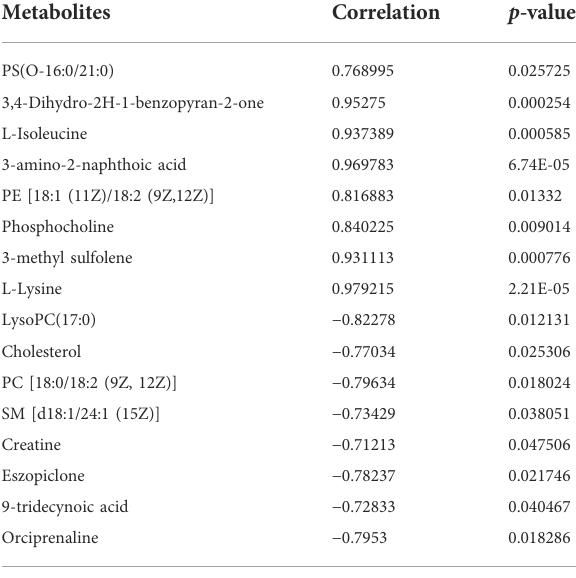
TABLE 3 List of Gclc-related differential metabolites.